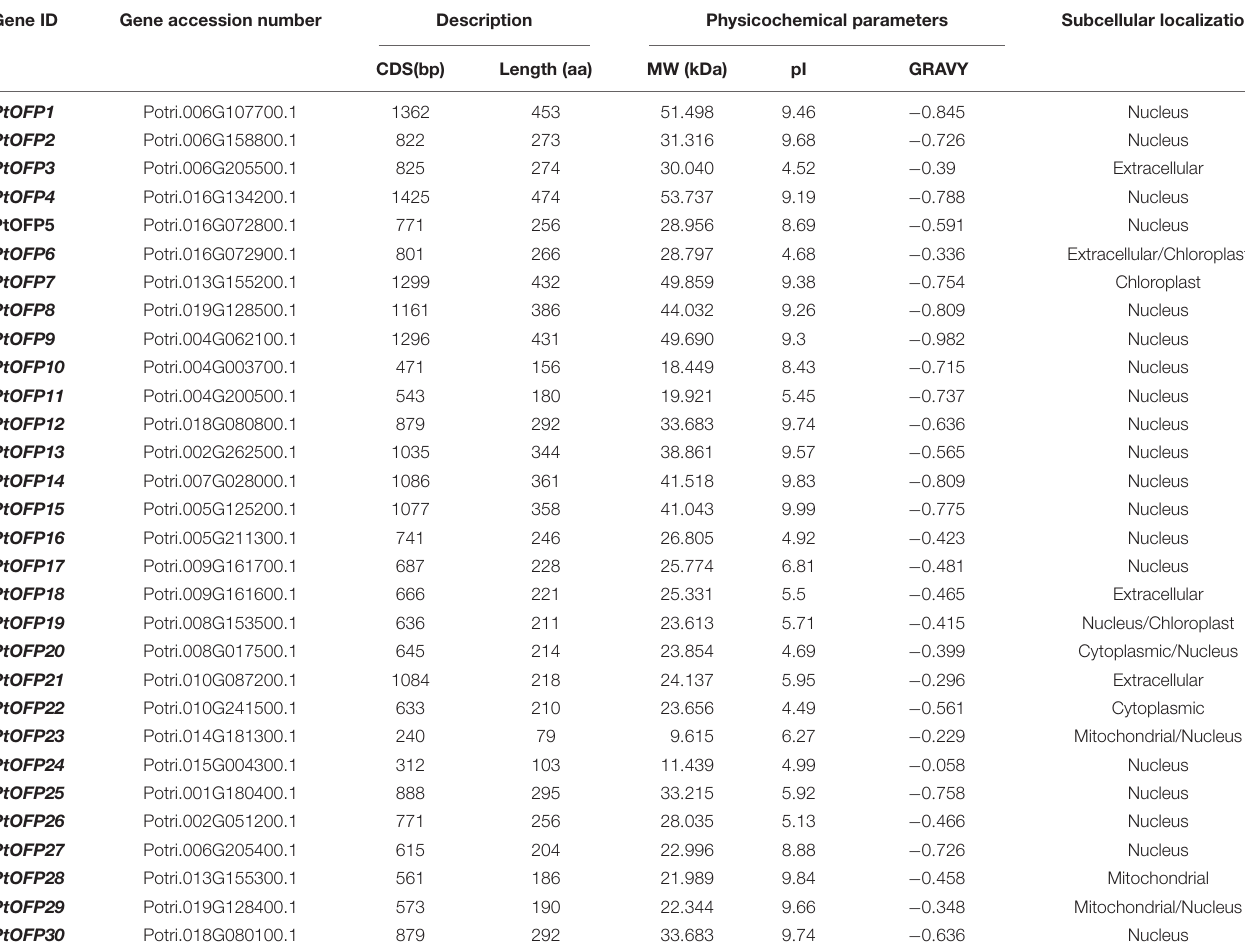
TABLE 1 | The OFP gene family in Populus trichocarpa along with their molecular